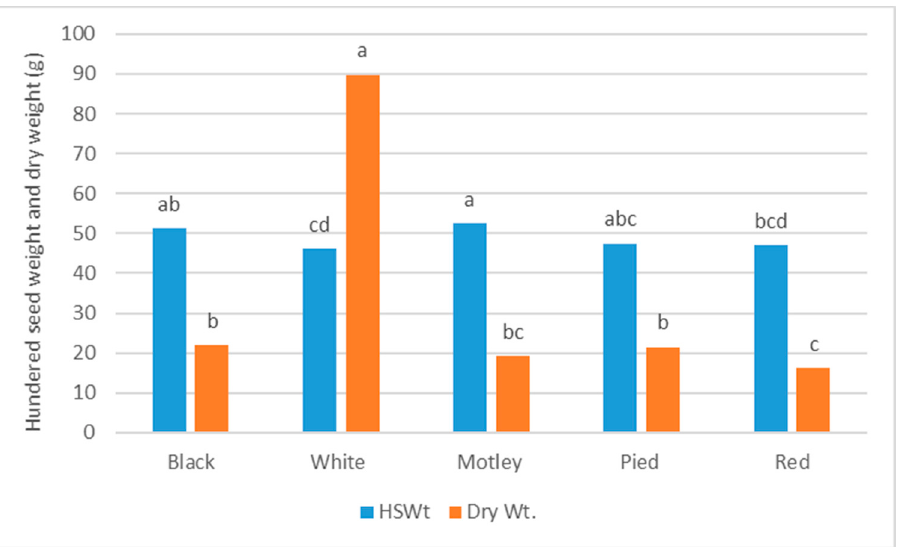
Figure 7. Mean comparisons among bean varieties for hundred seed weight (g) and dry weight (g)